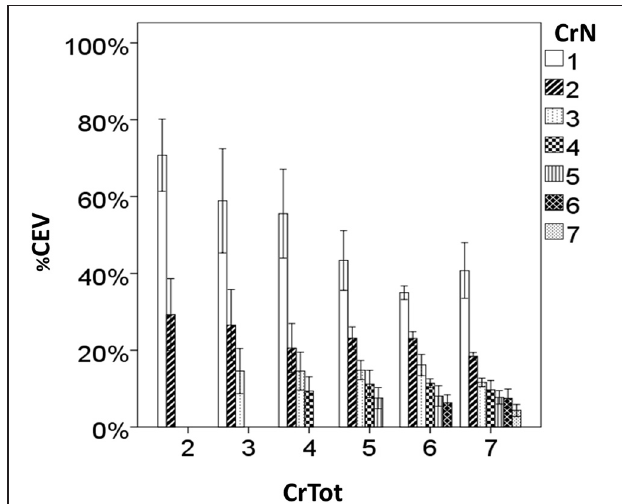
FIGURE 3 | Percent cough expired volume (%CEV) for each cough re-acceleration number (Cr N ), categorized according to the total number of cough re-accelerations within the epoch (CrTot).